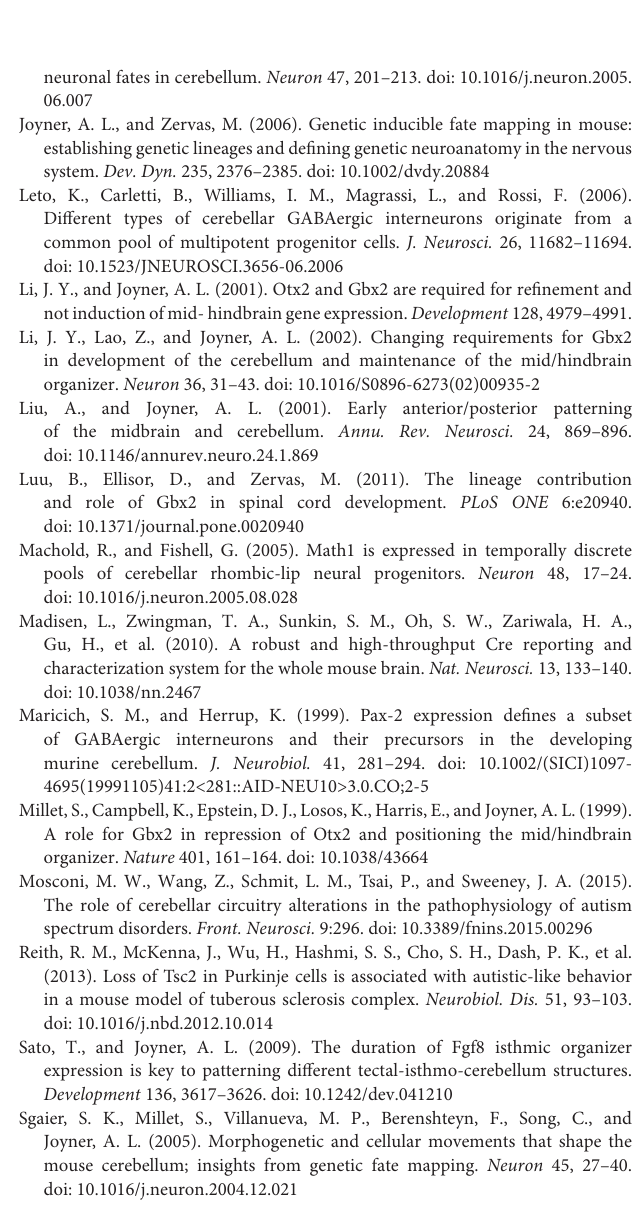
Supplemental Figure 3 | Summary schematic of the Gbx2 lineage contribution to Purkinje cells. The cerebellar primordium is located within the roster Hb (r1) and at E8.5 is partitioned into anterior r1 (rostral, indicated by the light green box) and posterior r1 (caudal, indicated by the light blue box). These domains are transposed 90 degrees to become the medial vermis and lateral hemispheres, respectively, of the adult Cb (based on Sgaier et al., 2005). Specifically, rostral-medial (RM) domains become posterior vermis (VP) while rostral-lateral (RL) domains become anterior vermis (VA). In contrast, the caudal-medial (CM) domains become posterior-hemisphere (HP) tissue and the caudal-lateral (CL) domains become anterior-hemisphere (HA) tissue. The density of stippling indicates the relative contribution to Purkinje cells. The Gbx2 lineage was marked at early (E7.5 and E8.5, orange), intermediate (E9.5, light blue), and late (E10.5 and E11.5, purple) embryonic time points and the distribution of Gbx2 -derived granule cells